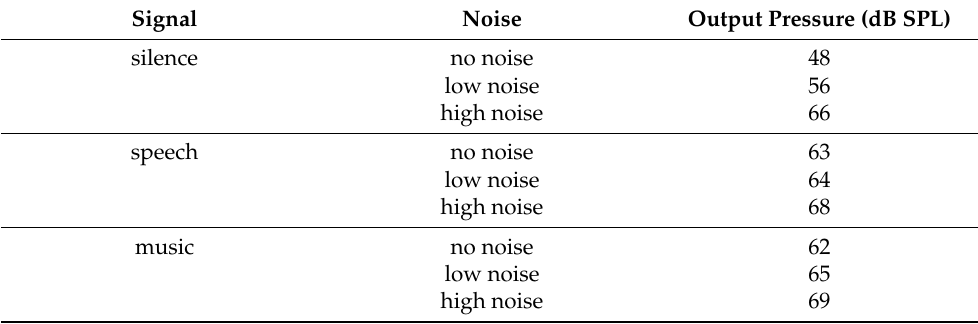
Table 2. The final intensity levels in the testing